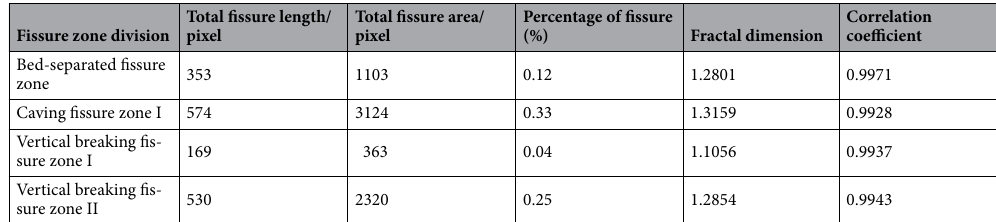
Table 2. Classification of fissure zone after the completion of 2–2 coal seam